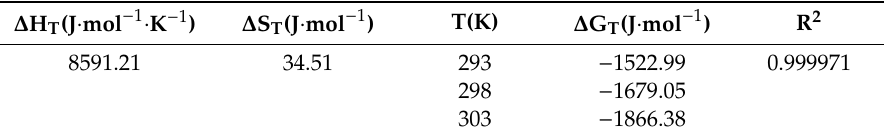
Table 6. Related thermodynamic parameters of gold